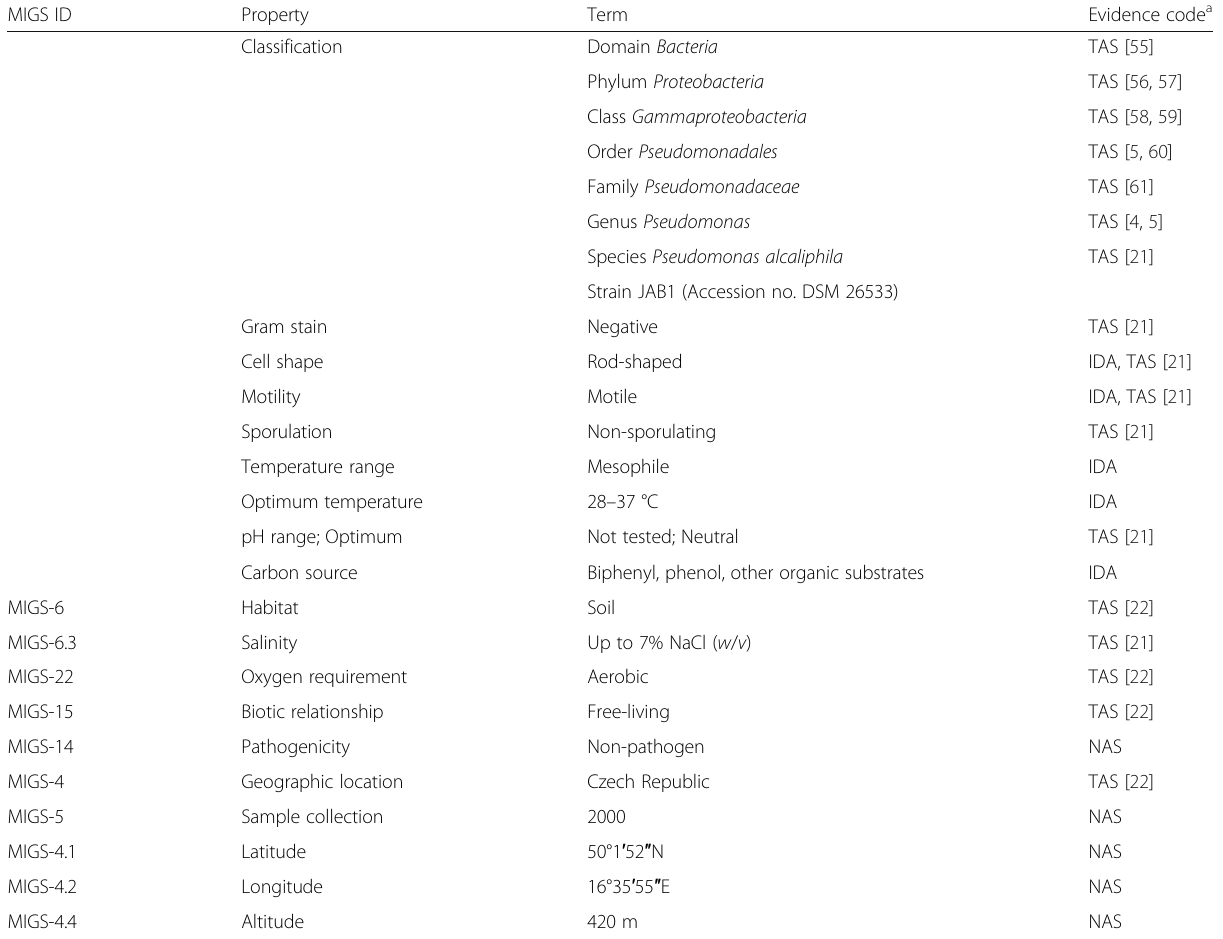
Table 1 Classification and general features of P. alcaliphila